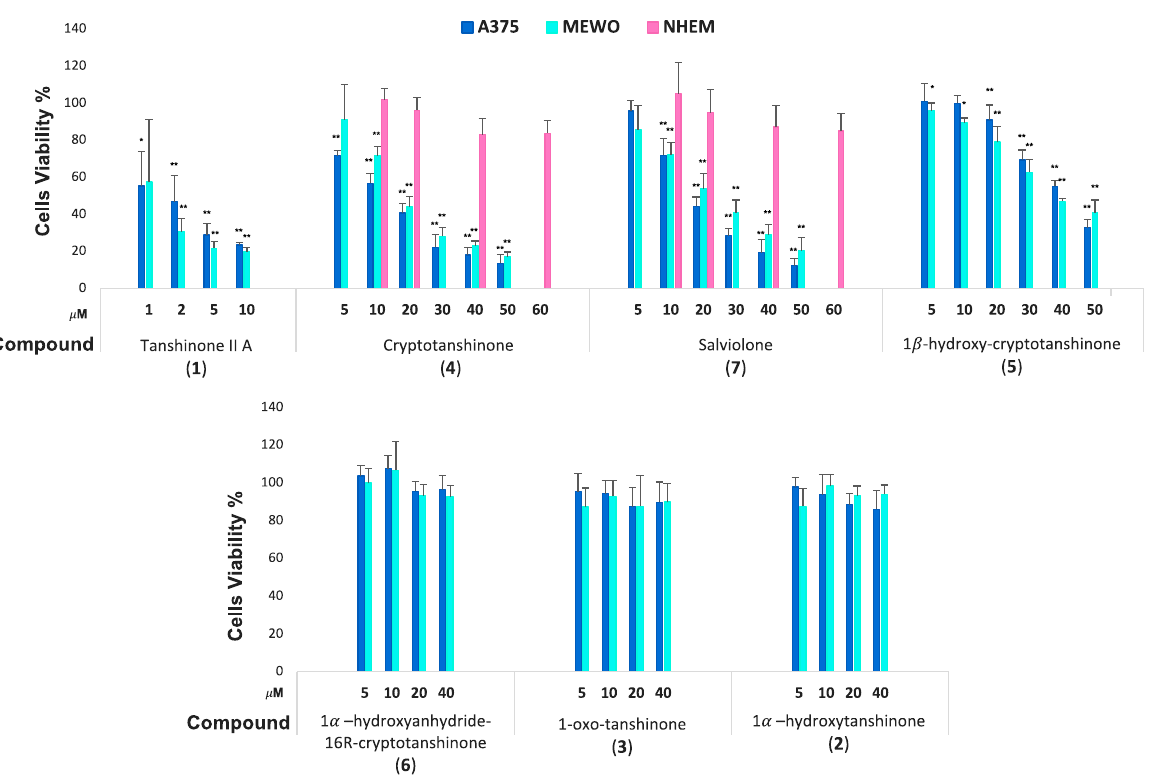
Figure 2. SRB cell viability assay in A375, MeWo melanoma cells, and NHEM cells in the presence of diterpene compounds. SRB viability assay of MeWo (light blue) and A375 (blue) melanoma cell lines with compounds 1 – 7 . SRB viability assay of the normal human epithelial melanocyte (NHEM) cell line (pink) with compounds 4 and 7 . Data acquired calculating the average ± SD of values obtained from three to four independent experiments were compared to data from non-treated control (* p < 0.05; ** p < 0.01).